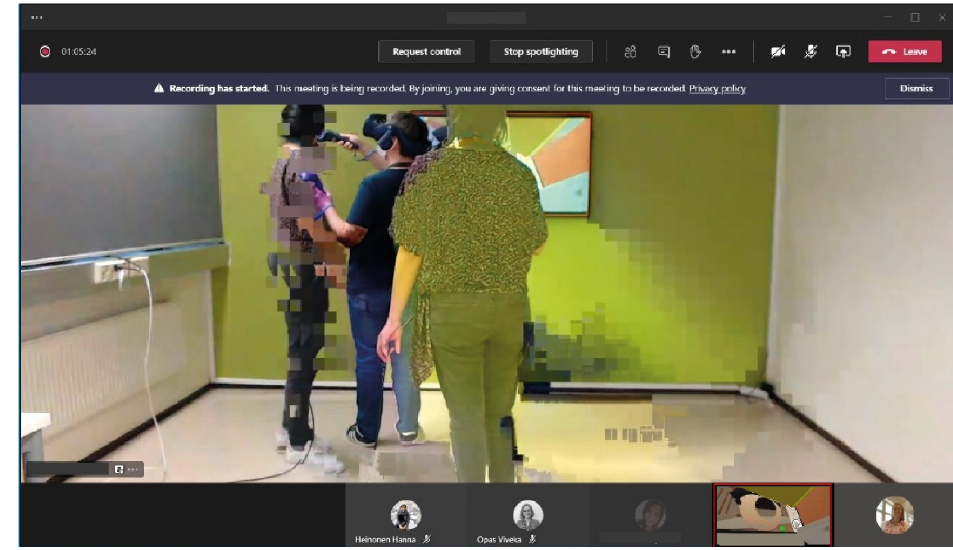
Figure 9. Network issues during remote observation in Case 3. The facilitator is seen twice in the